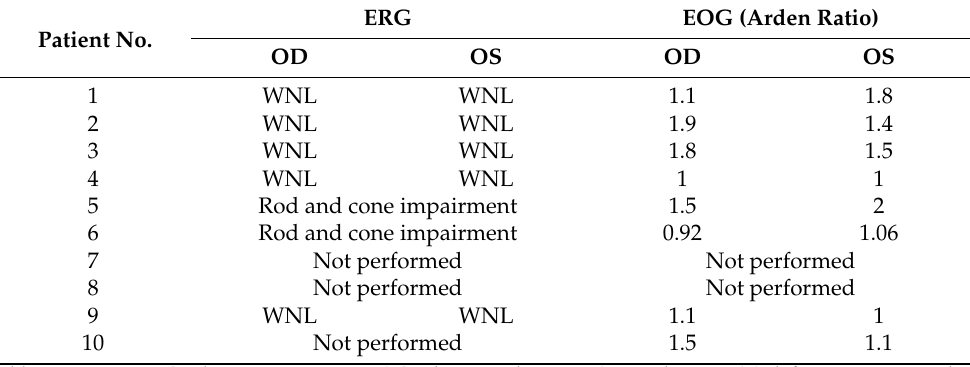
Table 4. Electrophysiologic study of